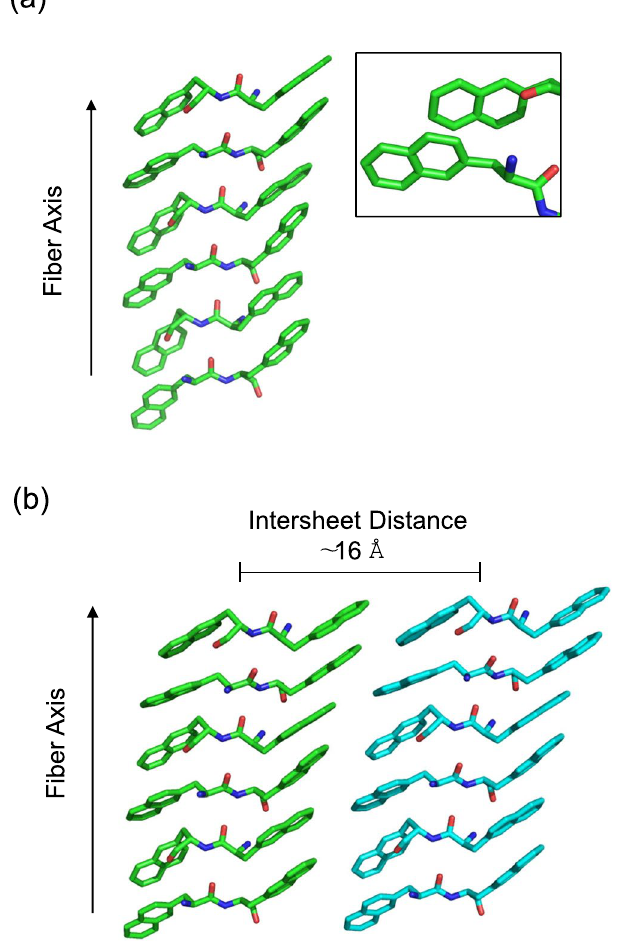
Figure 7. Three-dimensional model of the assembly formed by the peptide moiety of 2Nal 2 /Gd-2Nal 2 . In panel ( a ) the cross β -structure of a single β -sheet is reported. In the inset the extensive hydrophobic interactions established by Nal side chains are highlighted. The possible direct interactions between two facing β -sheets is reported in panel ( b ).